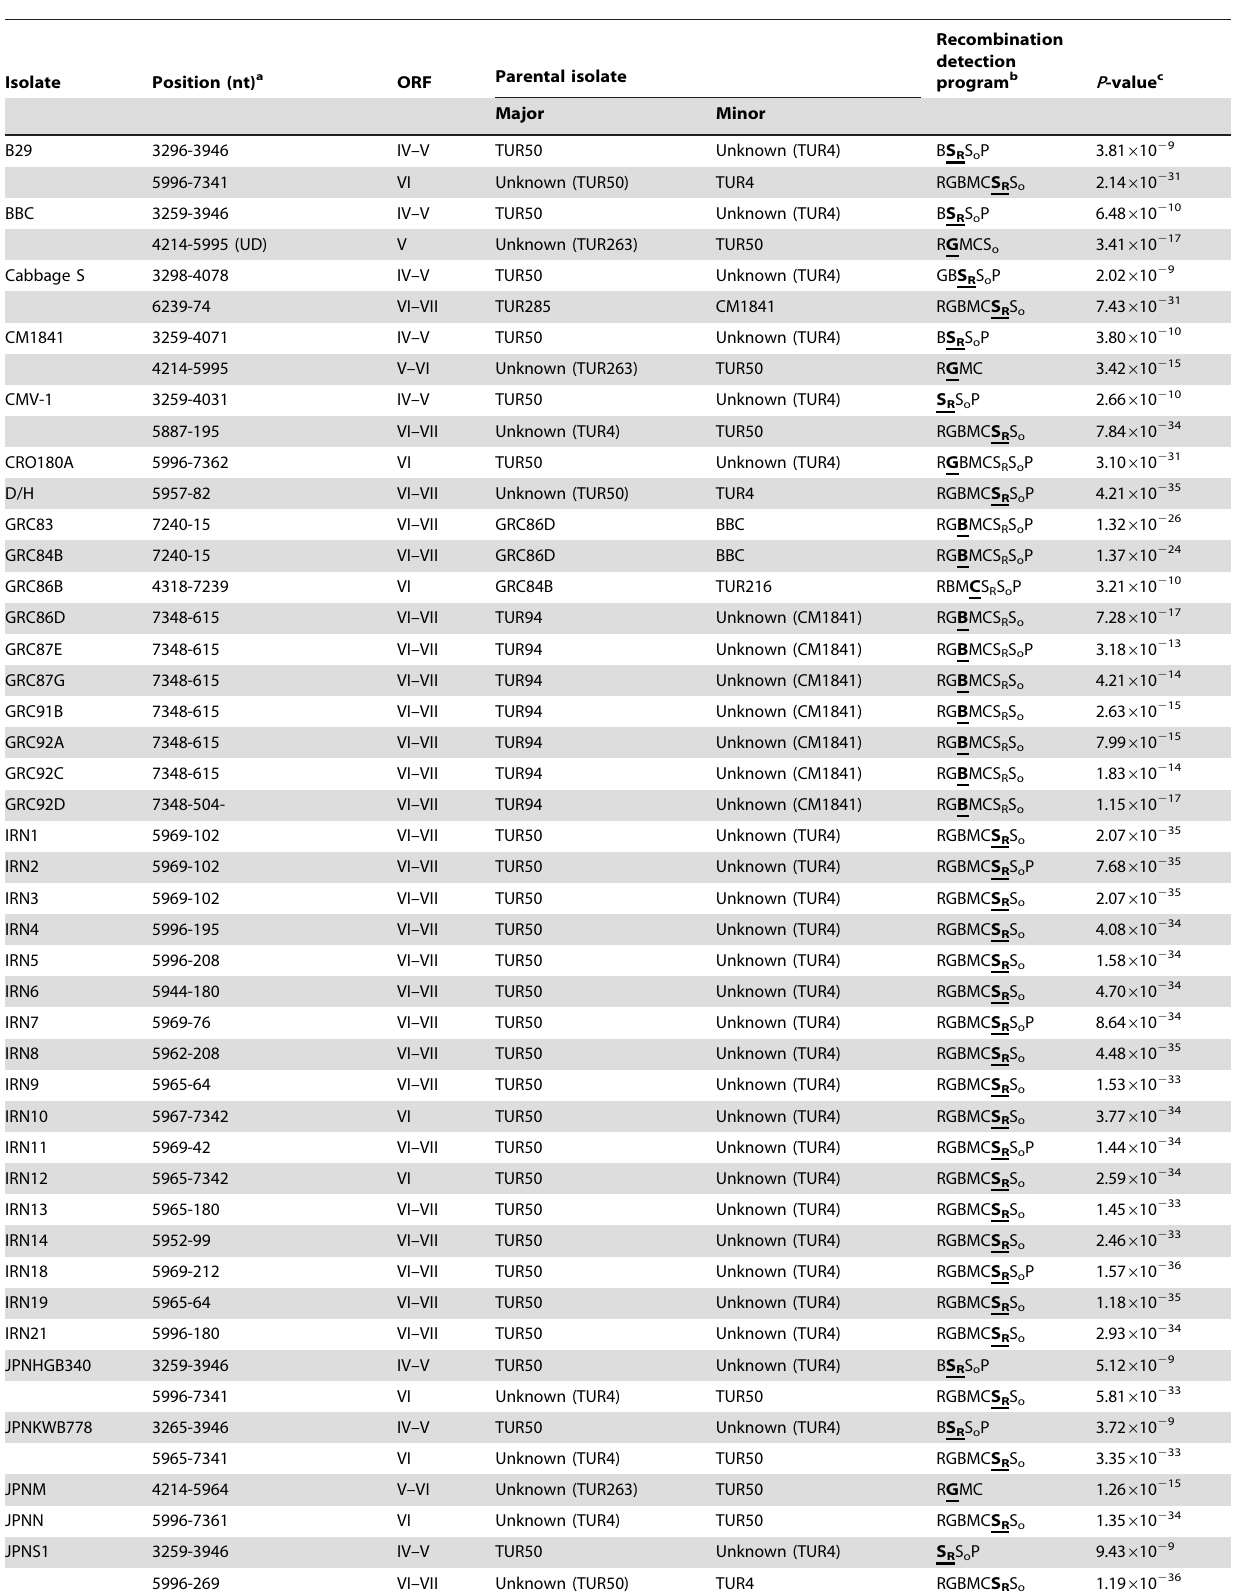
Table 1. Tentative and clear recombination sites in Cauliflower mosaic virus genomes.